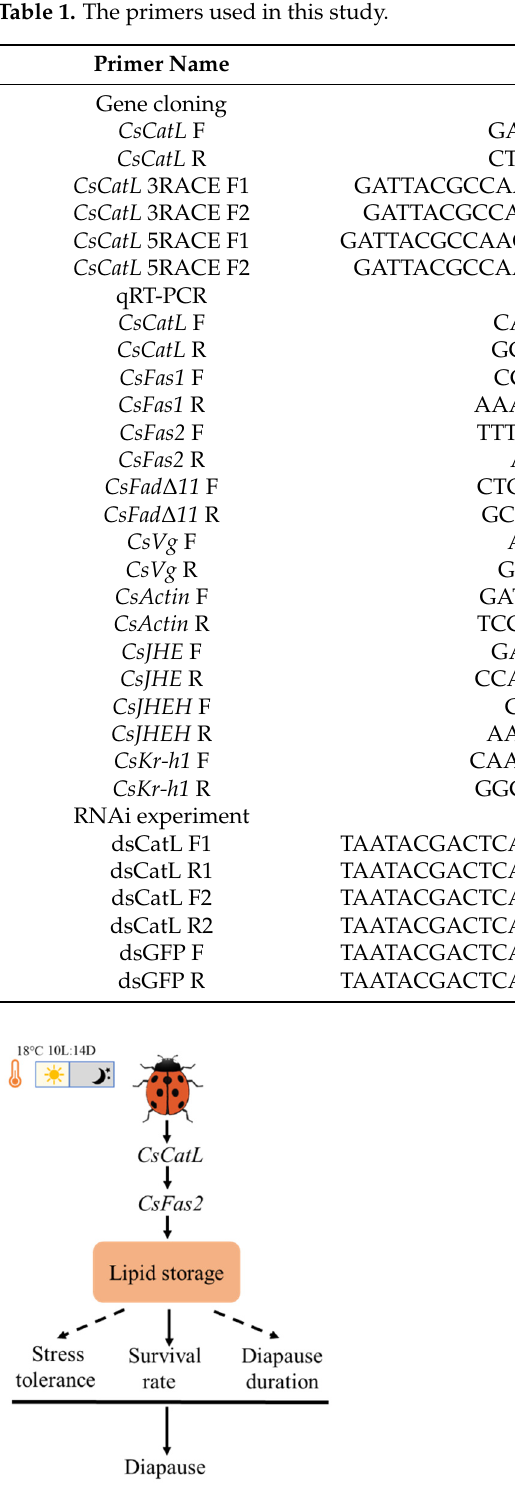
Figure 7. Model of how CsCatL promotes diapause preparation in C. septempunctata .